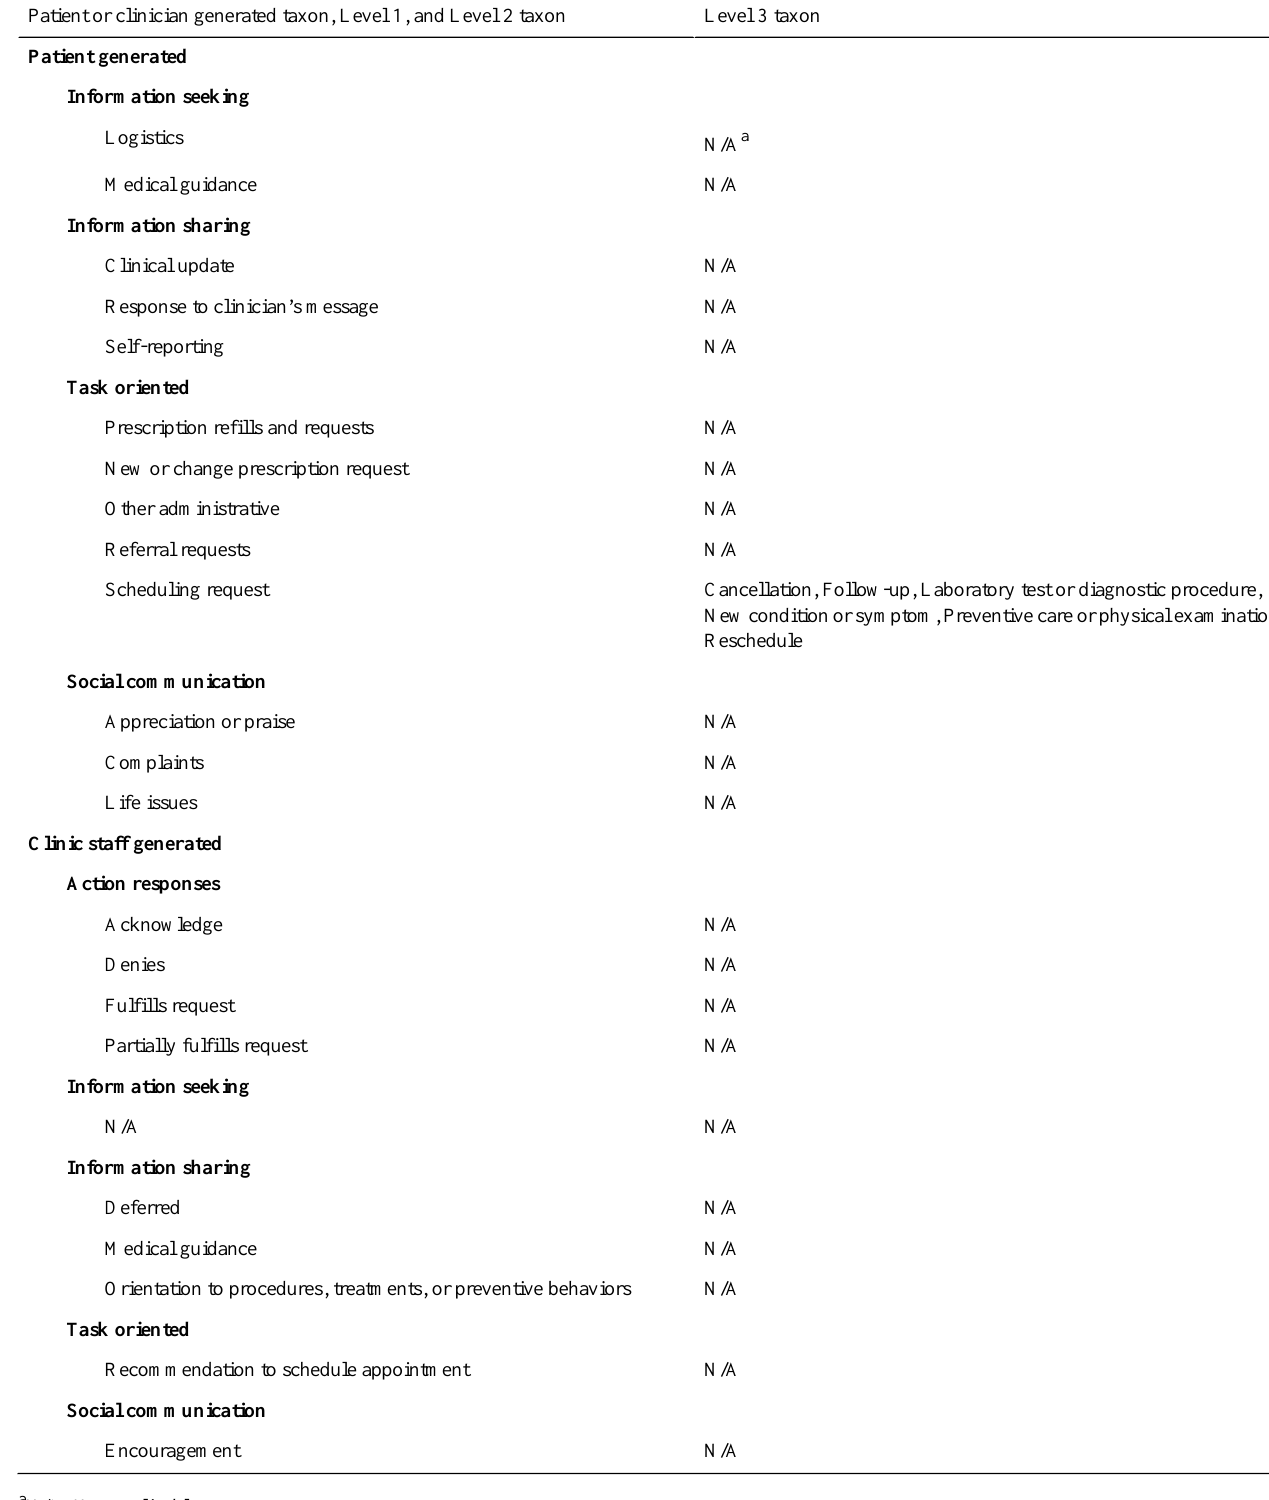
Table 1. Secure message taxonomy.